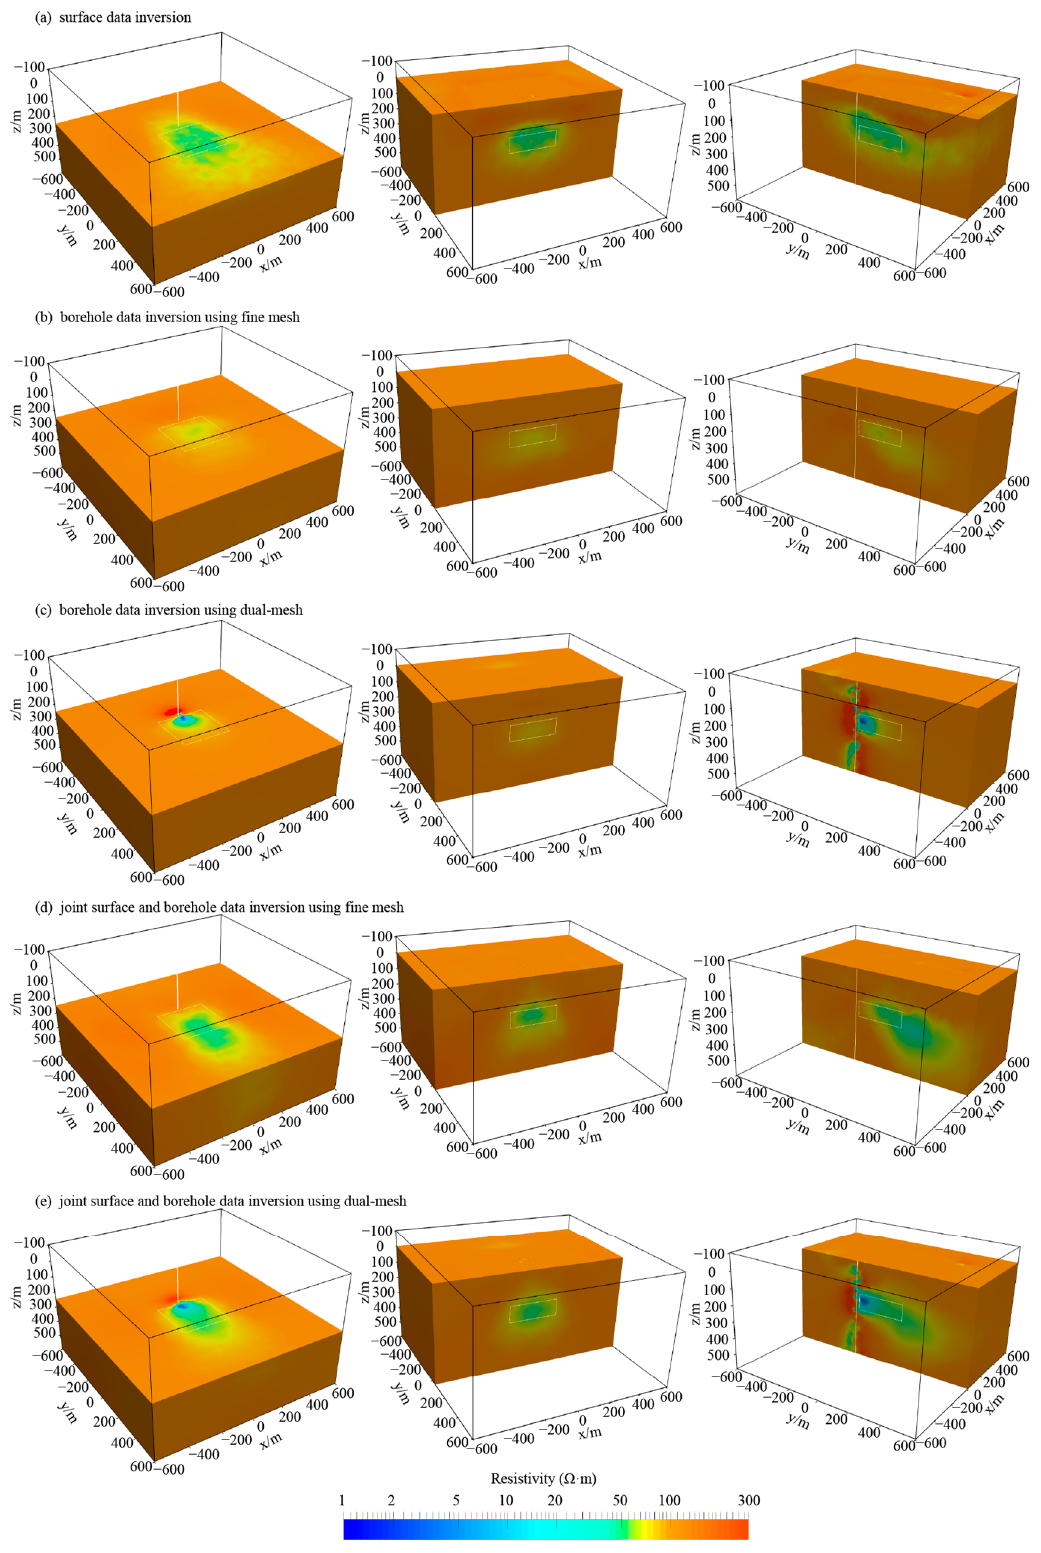
Figure 5. Inversions of the surface data, borehole data, and joint surface and borehole data for the model in Figure 3.